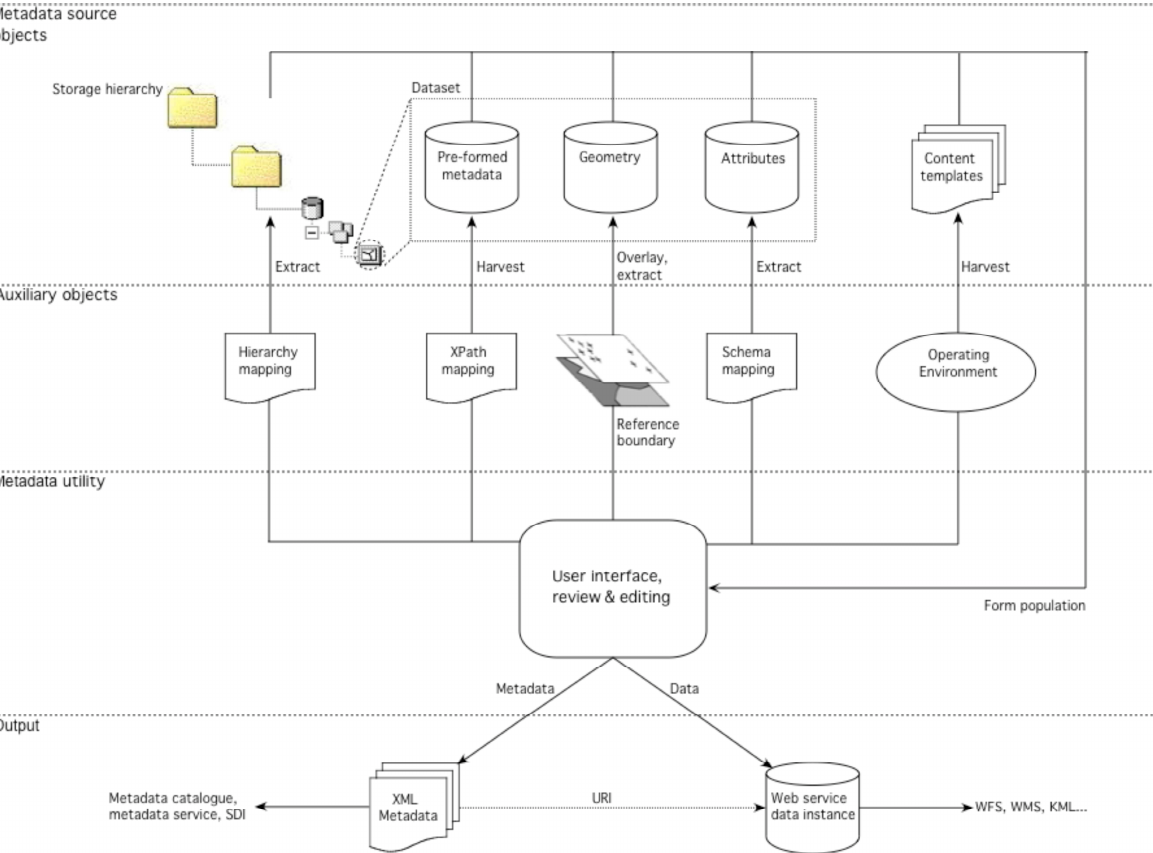
Figure 4. An overview of approach’s routines, the metadata sources on which they operated (assisted by its associated auxiliary object). Computed values are displayed on a form interface where they may be modified by hand prior to validation and eventual